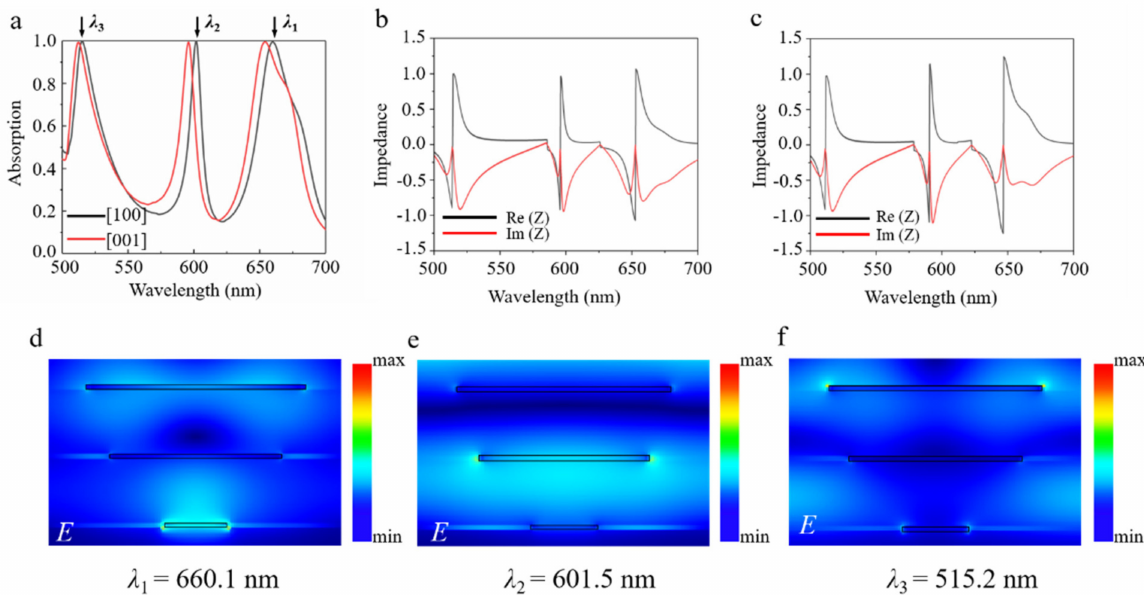
Figure 3. ( a ) Simulated absorption spectra for the proposed triple layer α -MoO 3 structure along [100] and [001] directions, respectively. ( b , c ) The calculated real and imaginary parts of the effective impedance along the [100] and [001] directions, respectively. The optimized geometrical parameters are listed as follows: h = 100 nm, w 1 = 105 nm, w 2 = 275 nm, w 3 = 345 nm, p = 500 nm. ( d – f ) The calculated distribution of total electric field at the resonant wavelengths of λ 1 = 660.1 nm, λ 2 = 601.5 nm, and λ 3 = 515.2 nm, separately.